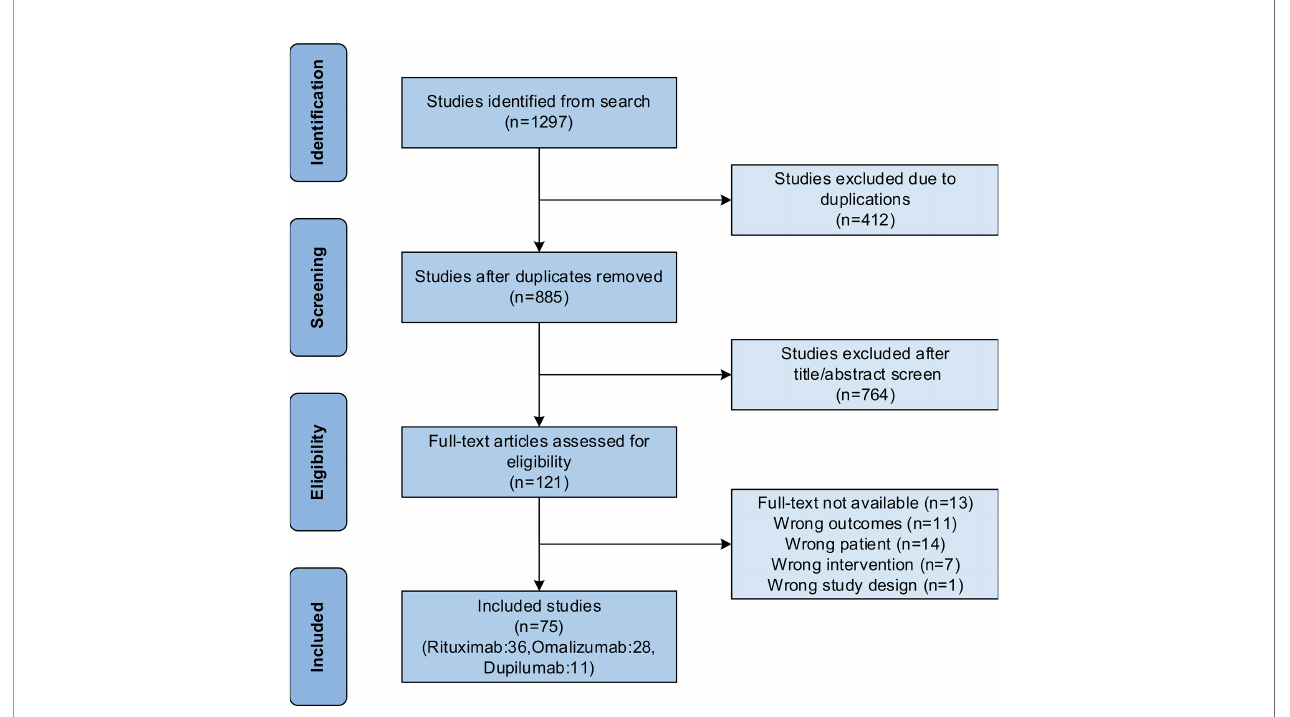
FIGURE 1 | Flow chart of study selection following the Preferred Reporting Items for Systematic Reviews and Meta-Analyses (PRISMA)